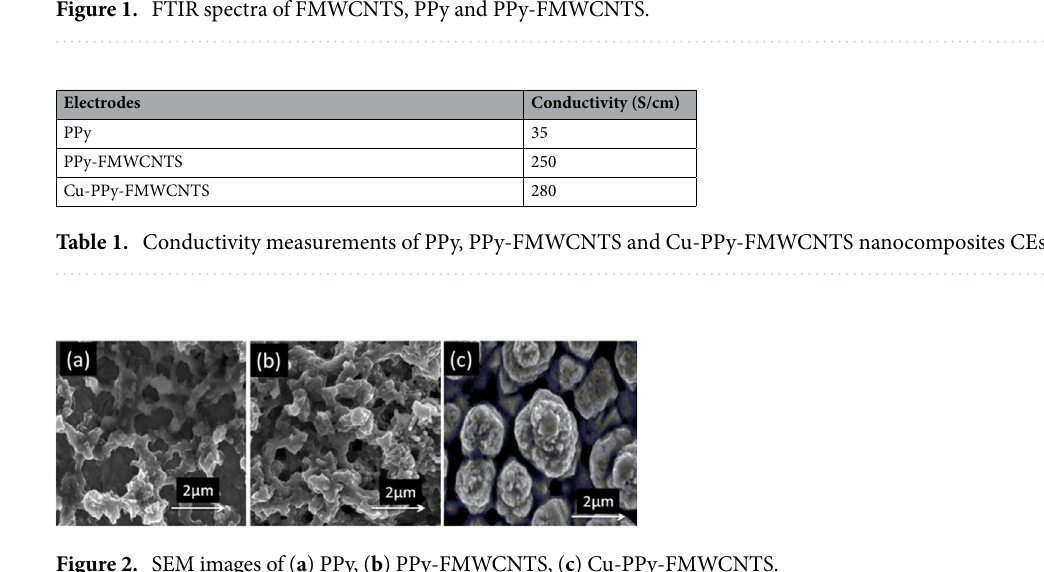
Figure 1. FTIR spectra of FMWCNTS, PPy and PPy-FMWCNTS.